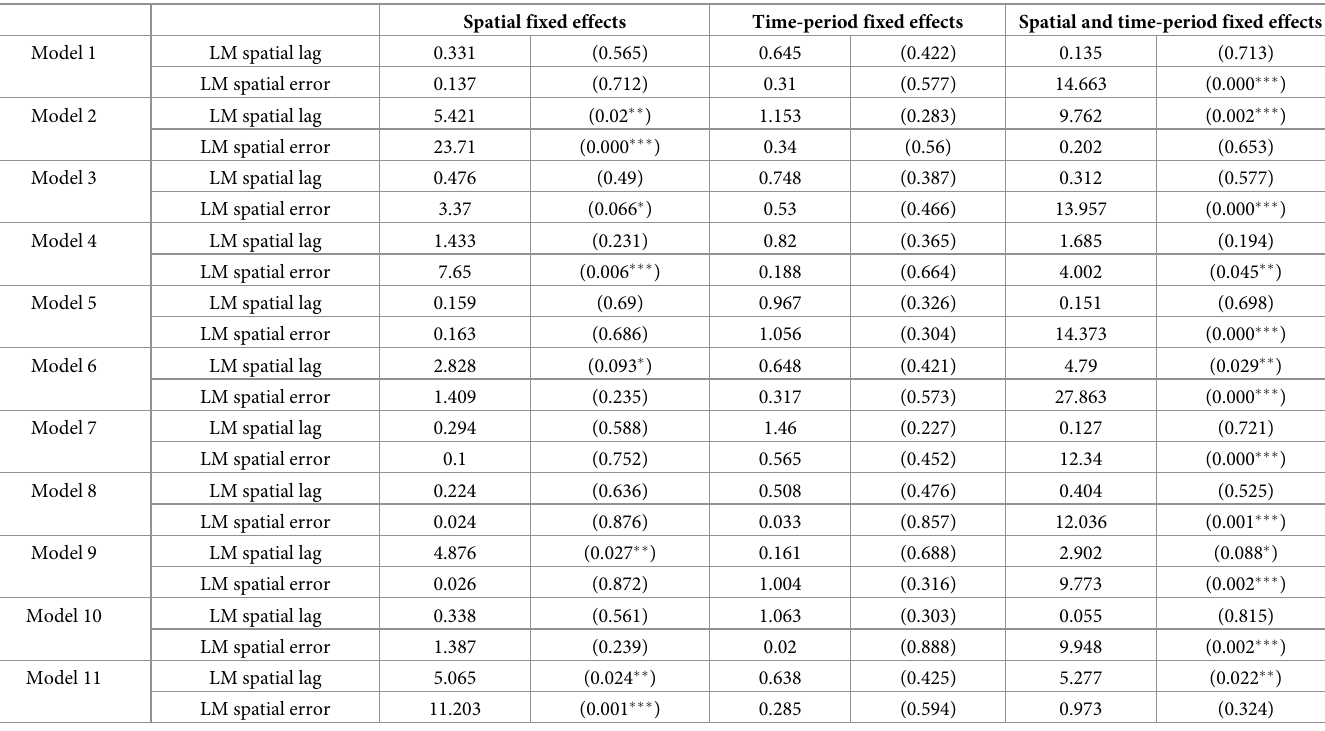
Table 4. The LM test for the existence of the spatial lag or the spatial error in the